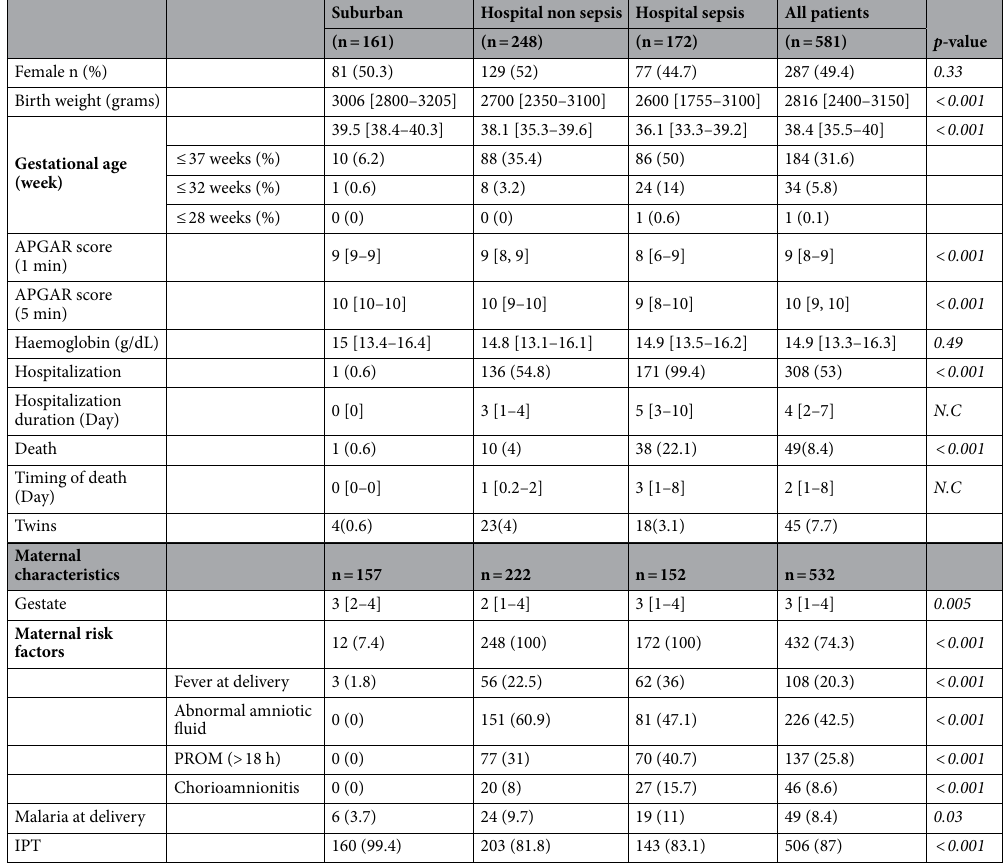
Table 1. Patient characteristics. Qualitative data are expressed as numbers and frequency and quantitative data are expressed as medians and IQR (inter-quartile range: [Q1–Q3]). Qualitative variables were compared using the Chi-squared test (or Fisher’s exact test for small expected numbers). Anova test (or the Kruskal– Wallis test when distribution was not normal or when homoscedasticity was rejected) was performed to compare groups (statistically significant test p ≤ 0.05 ). PROM, Premature Rupture of Membranes; IPT, Intermittent Preventive Treatment of malaria; APGAR , neonatal adaptation